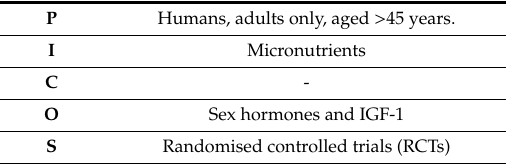
Humans, adults only, aged > 45